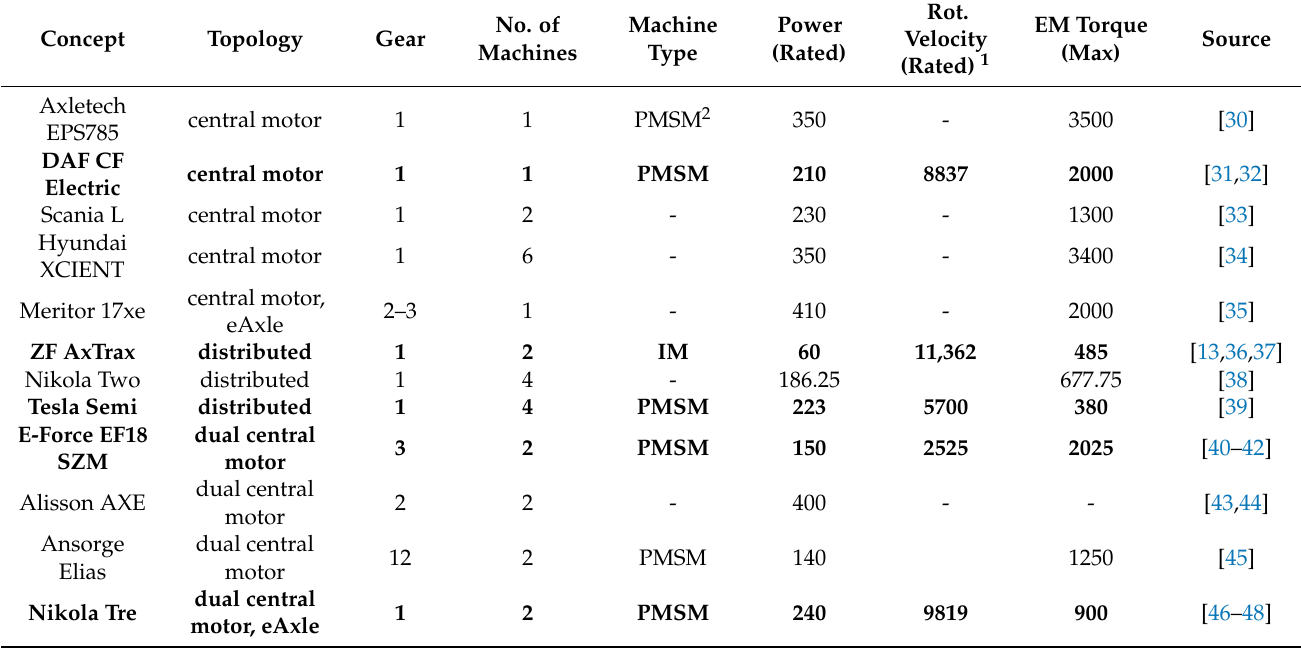
Table 1. Summary of heavy-duty trucks or axles of various manufacturers and their respective powertrain topology parameters. Bold concepts are simulated in this study. Empty fields indicate unknown information. (Note: EM: electrical machine; PMSM: permanent magnet synchronous machine; IM: induction